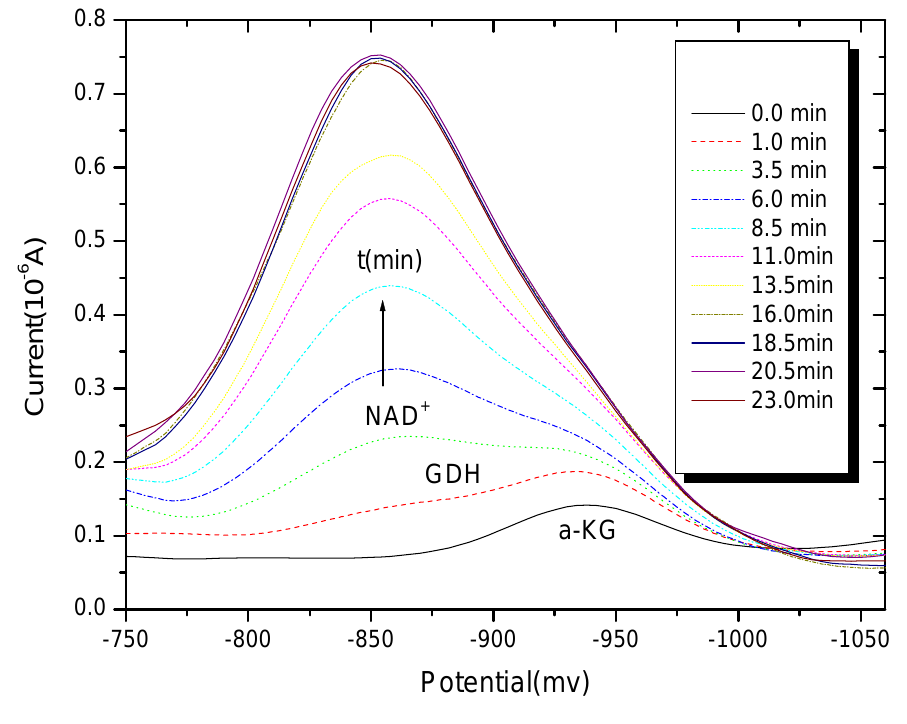
Figure 1. Differential-pulse polarography of GDH enzyme system; in a 0.1M pH=6.5 Tris-HCl buffer solution; 0.002M α -KG; 0.0002M NADH; 0.01M NH Scan rate: 5